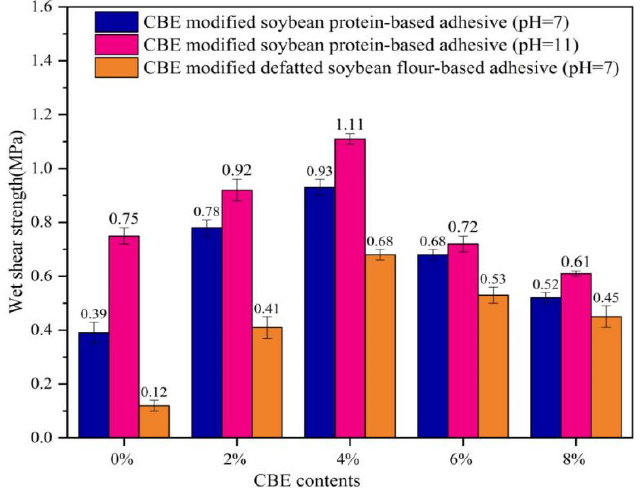
Figure 8. Effect of CBE content on wet shear strength of soybean ‐ based adhesive.